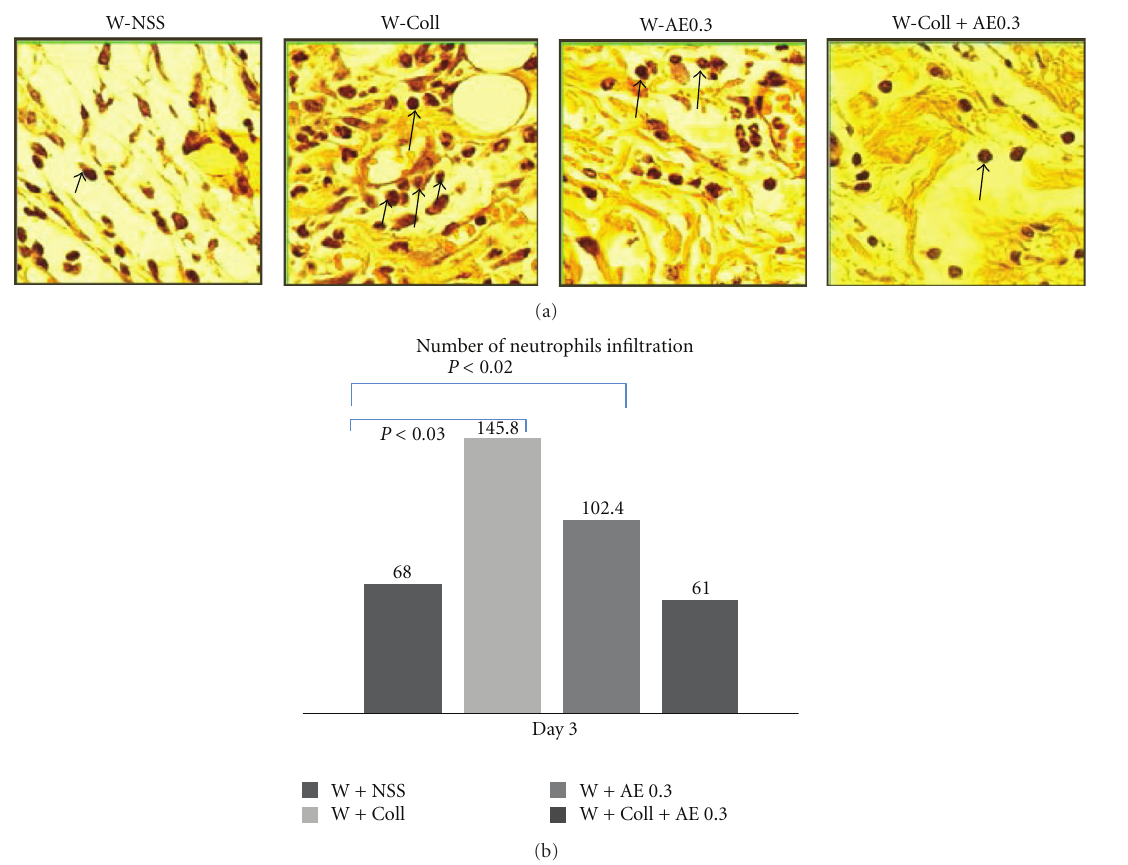
Figure 3: Histochemical analysis of neutrophil filtration within the wounded area on day 3. (a) Arrow indicates the expression of neutrophil infiltration (dark brown color). (b) The means ± SEM of numbers of infiltrating neutrophils per 0.25 mm 2 on day 3 in the W-NSS, W-AE, W-Coll, and W-Coll-AE